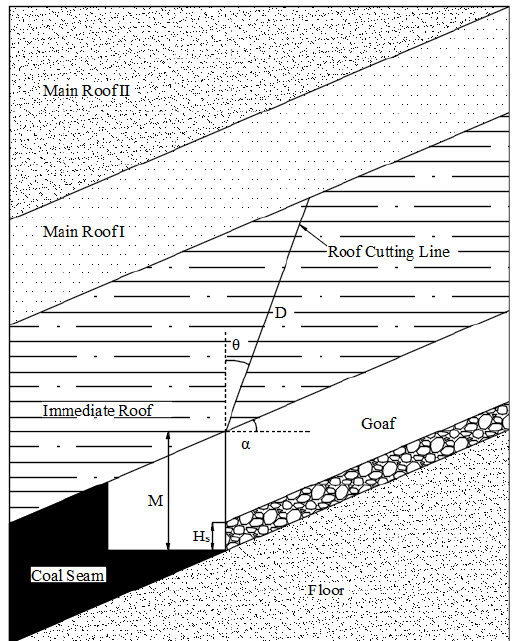
Figure 7. Determining roof-cutting depth.